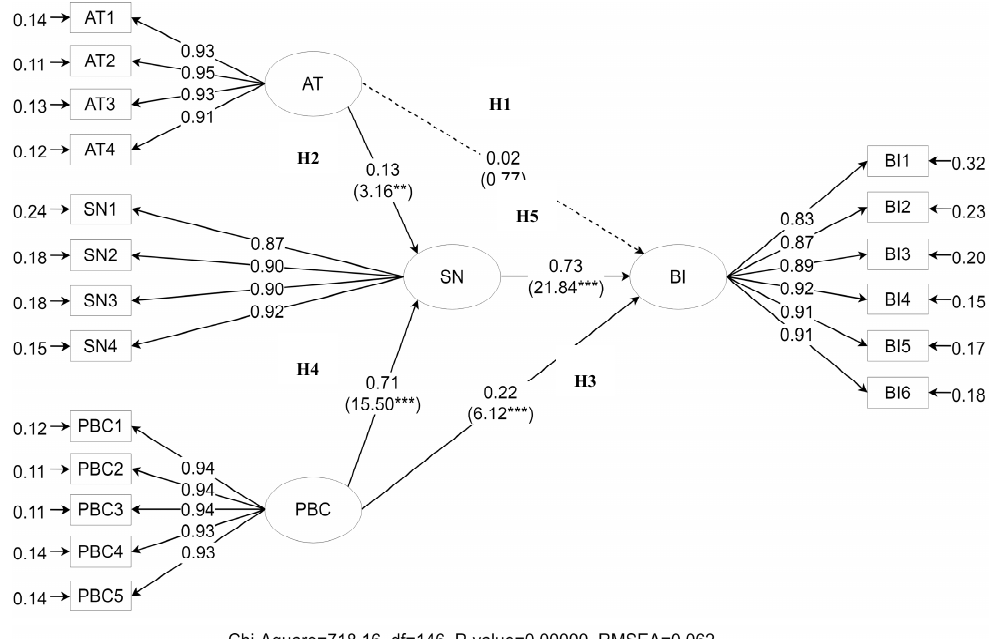
Figure 2. Path diagram of attitude (AT), perceived behavioral control (PBC), subjective norms (SN), and anti ‐ PM2.5 behavioral intentions (BI) of parents from the urban areas in Beijing.